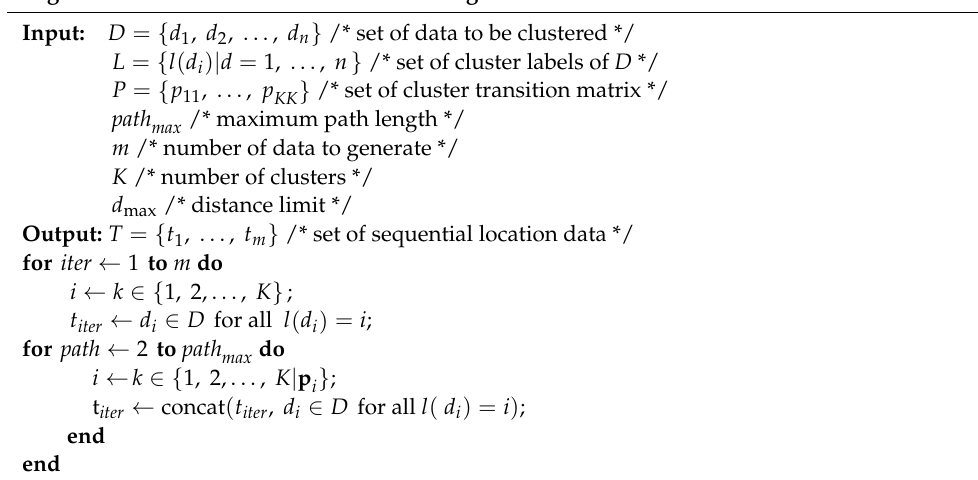
Algorithm 3 Movement Path Generation